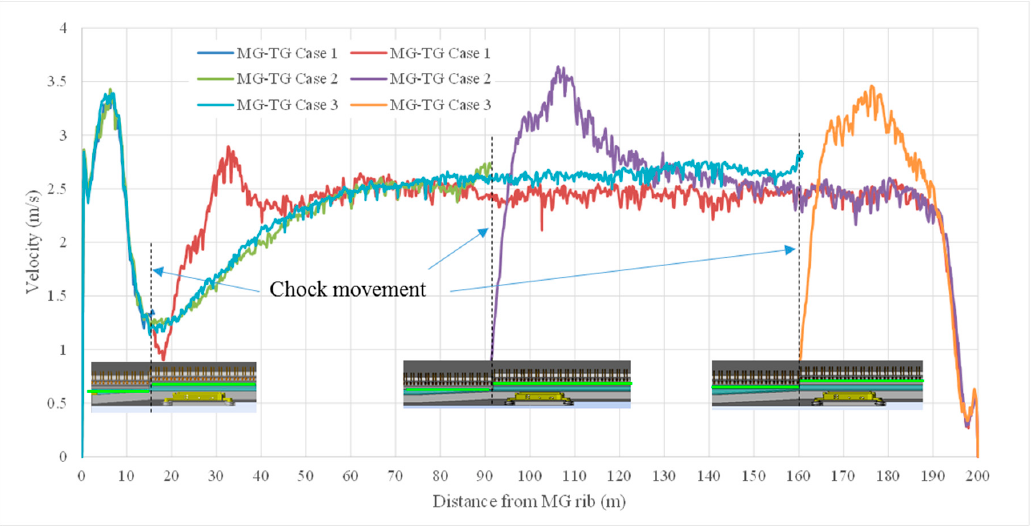
Figure 11. Velocity distribution along face for the MG-TG Cases.